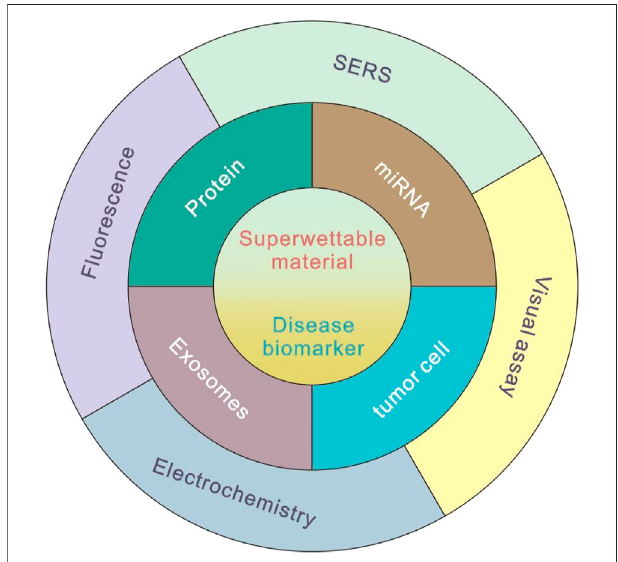
FIGURE 1 | Commonly used methods of superwettable biosensors for disease biomarker